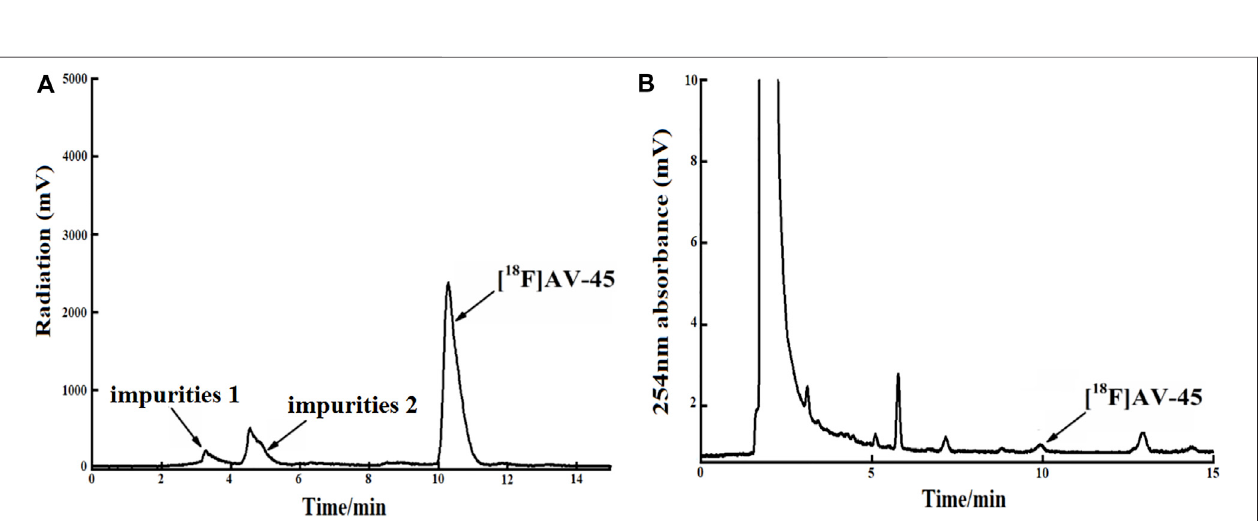
FIGURE 8 | The radiochemical purity of the preparation is 78.9% when the samples are collected until 1/6 of the peak height in the tailing edge of the radioactive peak. (A) The analytical HPLC radioactivity spectrum of fi nal product; Arrows mark the radioactive impurities and the [ 18 F] AV-45 peak. (B) The analytical HPLC UV spectrum of the fi nal product. The arrow points to the [ 18 F] AV-45 peak.